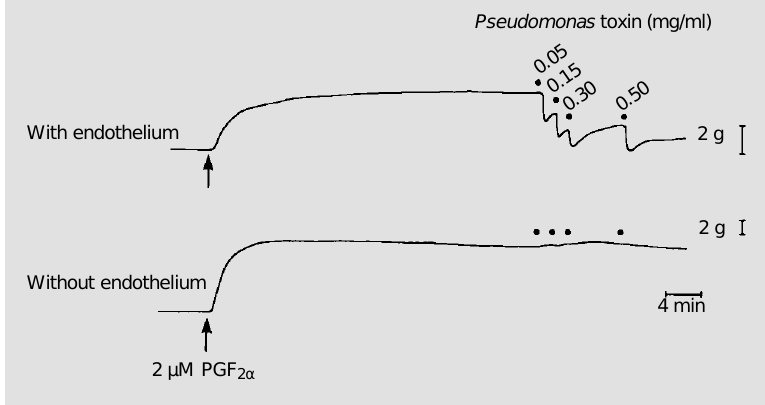
Figure 1 - Isometric tension recording of the effect of Pseudomonas aeruginosa lipopolysac- charide on canine epicardial coronary arteries (original tracing). Segments of left circumflex coronary artery, with and without endothelium, were suspended in organ chambers to measure isometric force. Segments were contracted with 2 µM prostaglandin F 2 a (PGF 2 a ). When the contraction in response to prostaglandin was stable, the vessels were exposed to increasing concentrations of endotoxin (0.05 to 0.50 mg/ml).